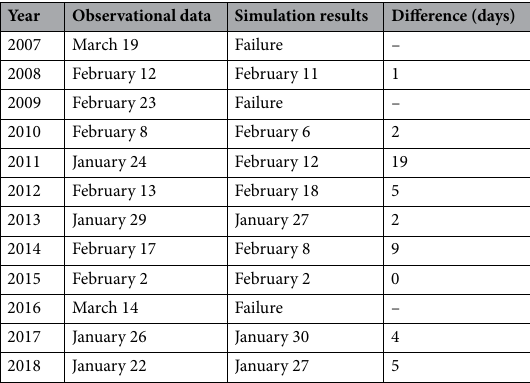
Table 1. Comparison of the simulation results with the observational data regarding the timing of